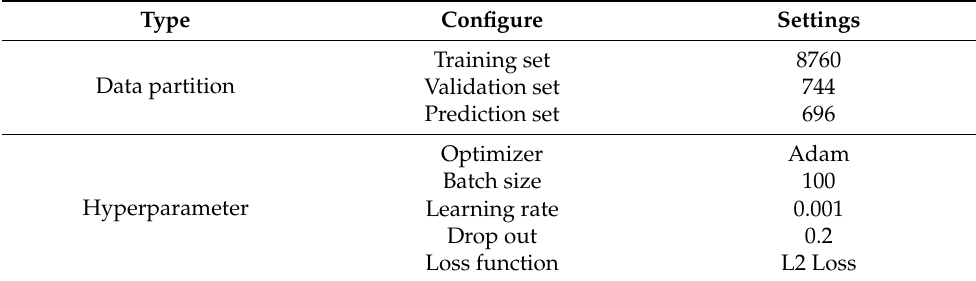
Table 4. Training data partition and hyperparameter settings for RNN-LSTM.